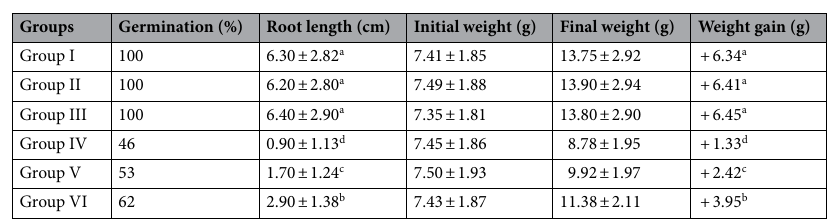
Table 1. Effects of uranyl acetate and sage application on selected physiological parameters. Group I: Control, Group II: 190 mg/L sage, Group III: 380 mg/L sage, Group IV: 0.1 mg/mL uranyl acetate, Group V: 0.1 mg/ mL uranyl acetate + 190 mg/L sage, Group VI: 0.1 mg/mL uranyl acetate + 380 mg/L sage. Data are shown as mean ± SD. 50 bulbs were used to determine germination percentage, and 10 bulbs were used to determine root length and weight gain. The averages shown with different letters (a–d) in the same column are significant at p <